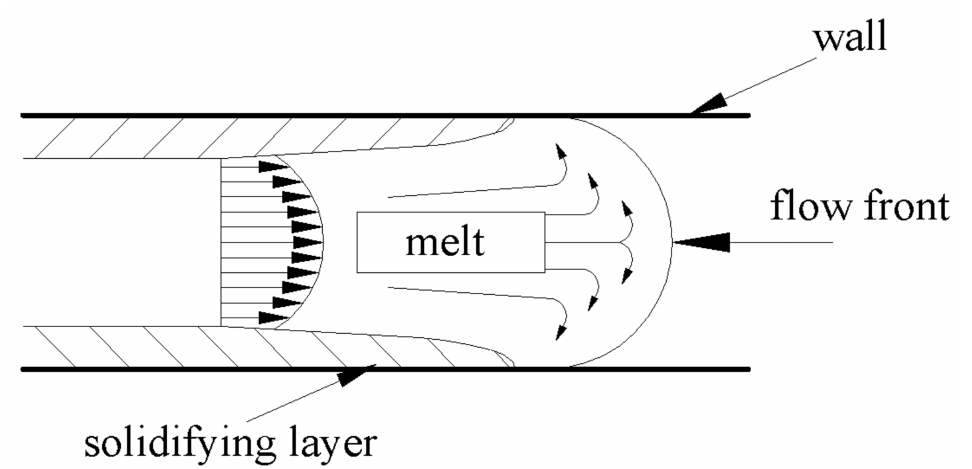
Figure 1. Fountain flow in the injection